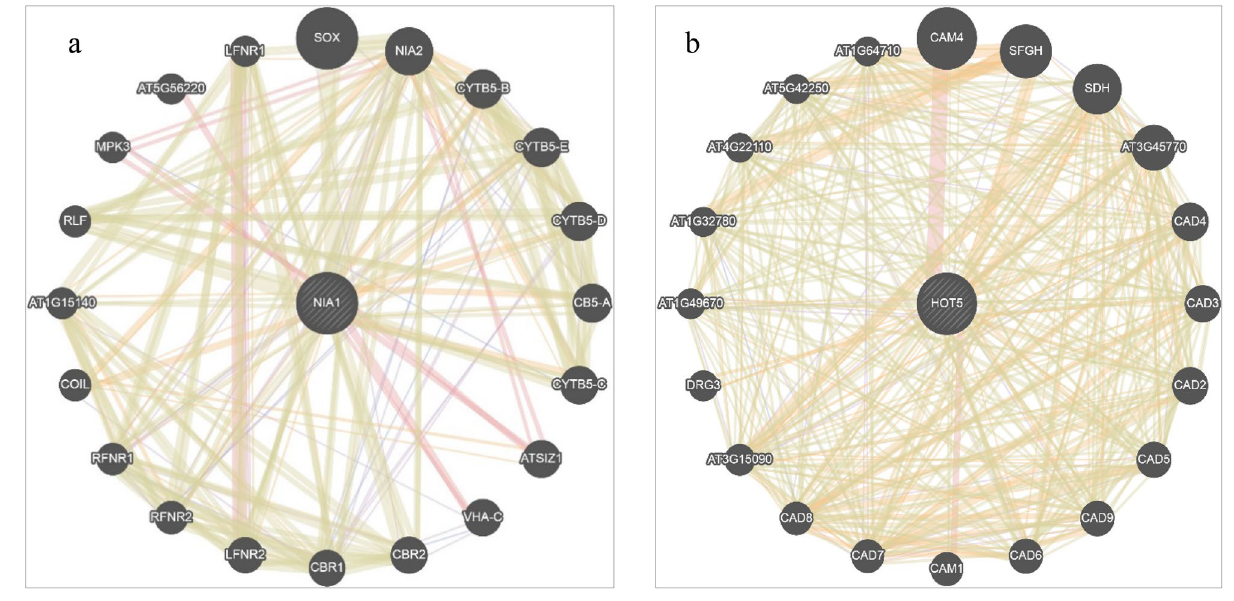
Figure 3. Predicted protein protein interaction network (PPIN) of TaNIA proteins ( a ) and TaGSNOR proteins ( b ) with other proteins. Images were created in GENEMANIA server (http:// www. genem ania. org).